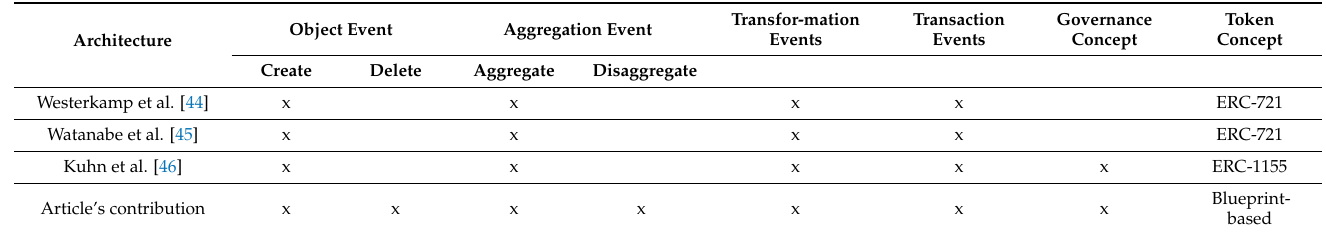
Table 1. Comparison of advanced blockchain-based traceability architectures.